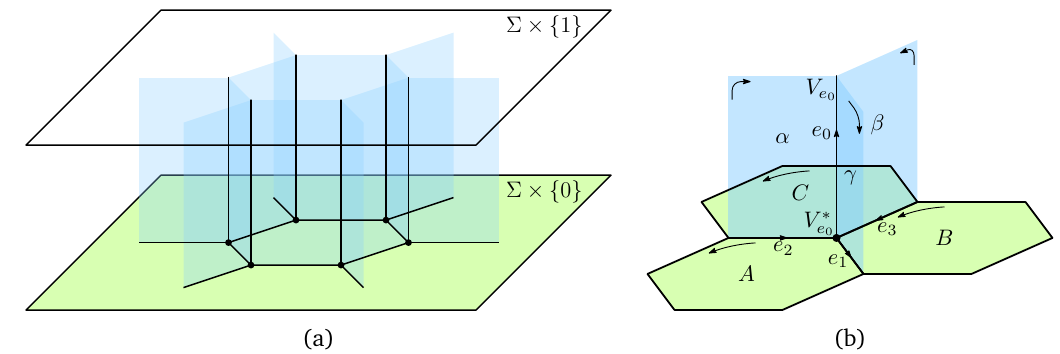
Figure 3: (a) A region of the three-manifold M Σ , where the surface Σ is endowed with a honeycomb-lattice cell decomposition. The physical boundary is depicted in green, the gluing boundary is white. (b) The assignment of state-sum variables to the two types of plaquettes with their orientation, as well as the vector spaces V and V ∗ associated to half-edges of M Σ e 0